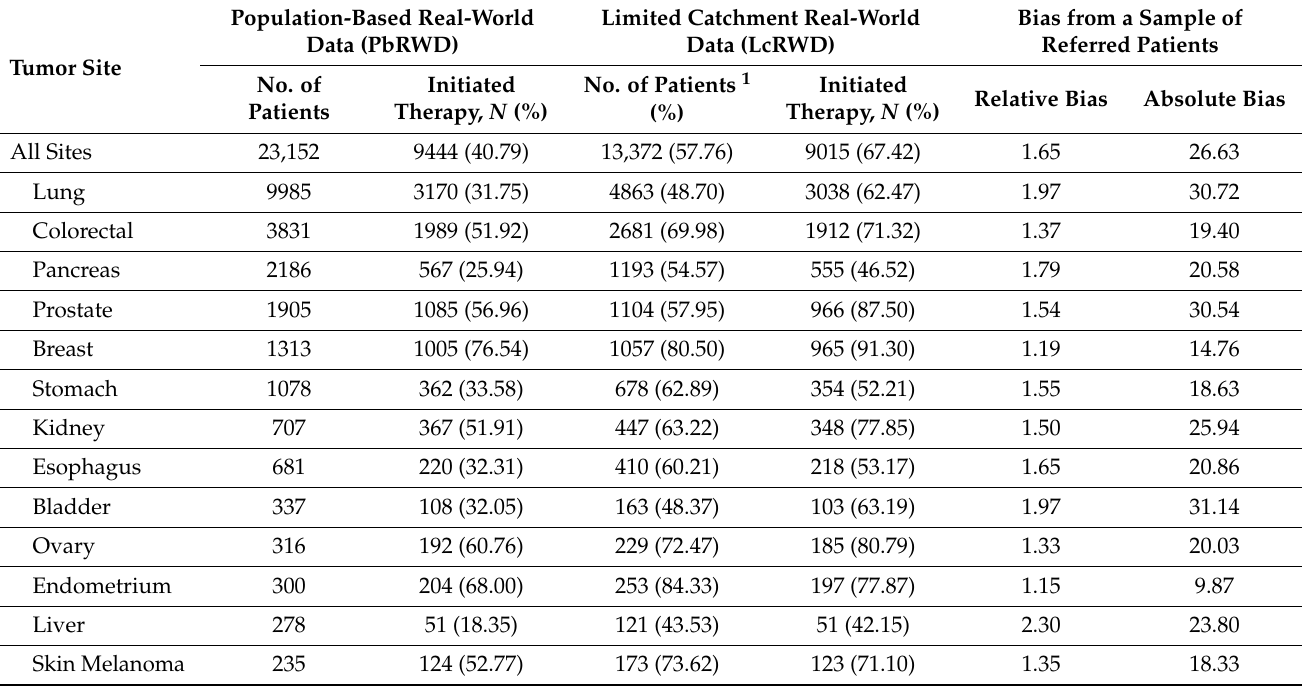
Table 1. Difference in the proportion of newly metastatic-diagnosed cancer patients in Alberta treated with systemic therapy (2010–2019) at the population-level versus among individuals referred to medical oncologists.